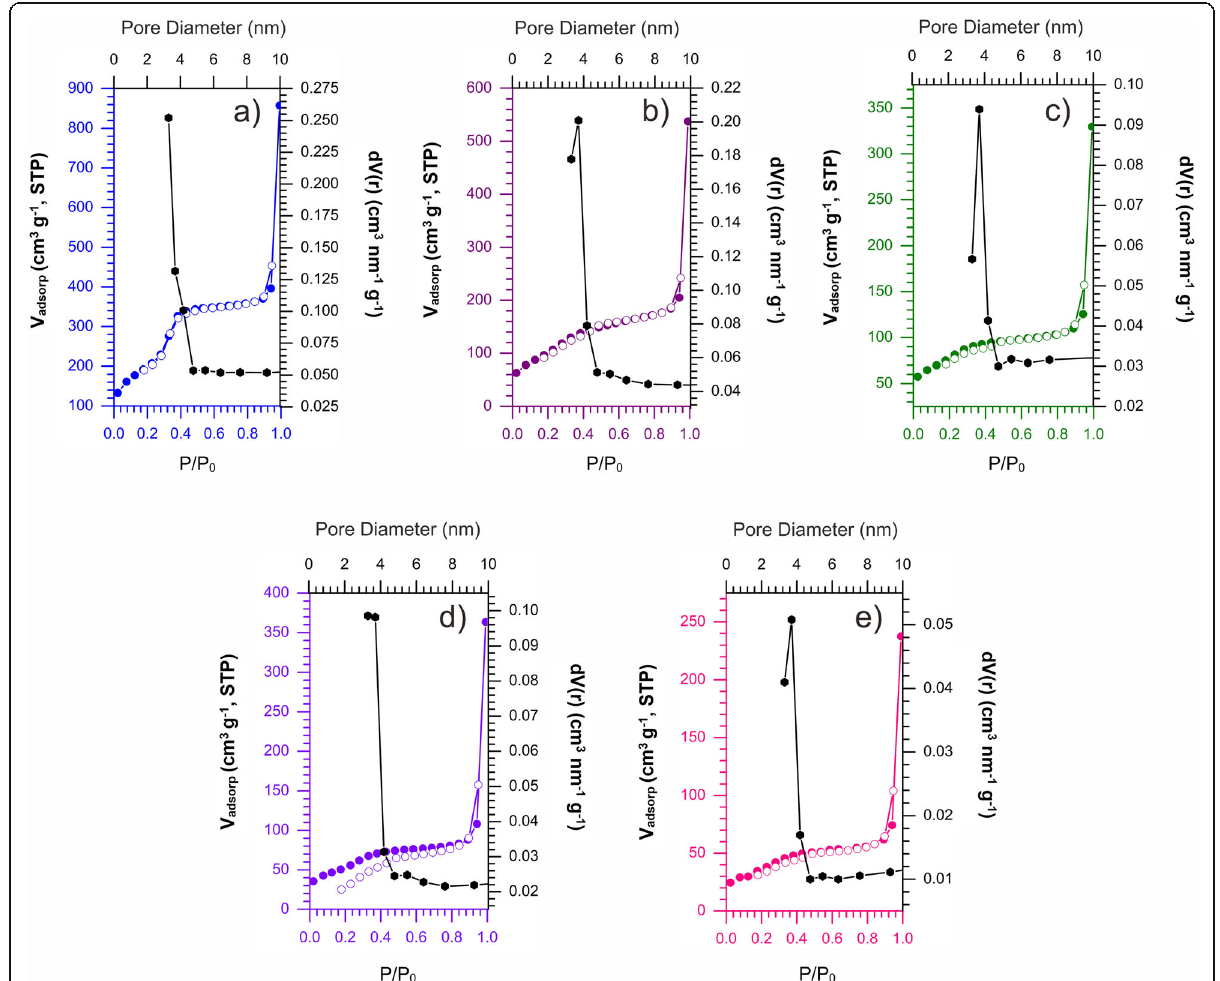
Fig. 6 N 2 adsorption isotherm and pore size distribution of (a) ZSM-5, (b) 20-ZnO/ZSM-5, ( c ) 34-ZnO/ZSM-5 ( d ) 54-ZnO/ZSM-5, and ( e ) 67-ZnO/ZSM-5